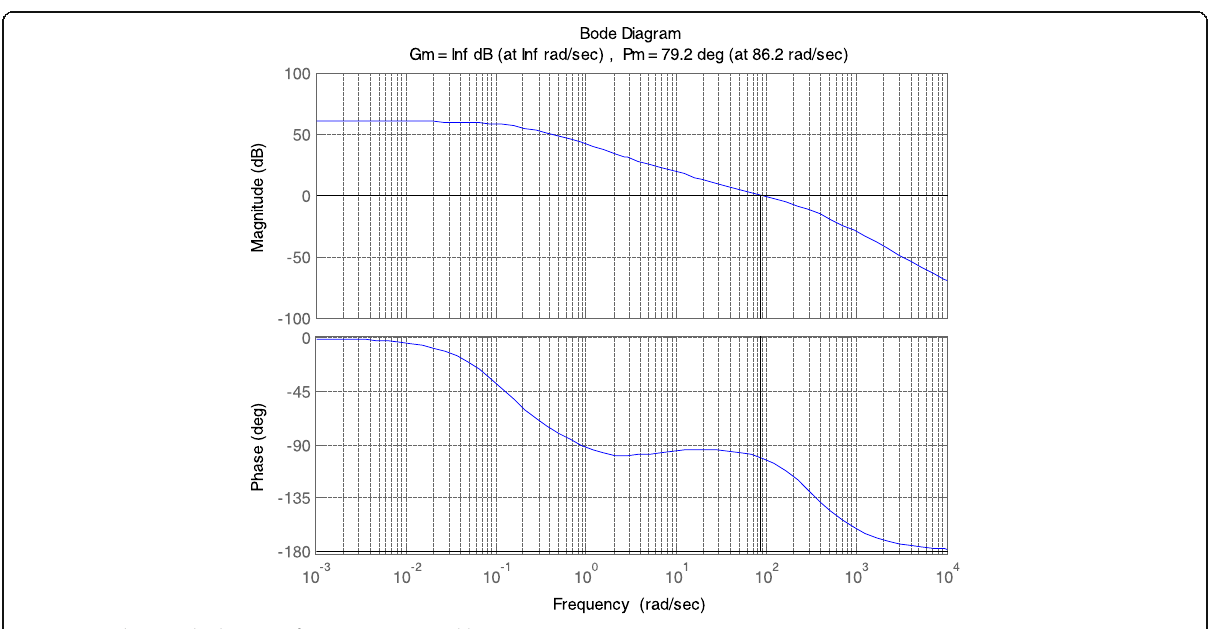
Fig. 6 Open loop Bode diagram of main system speed